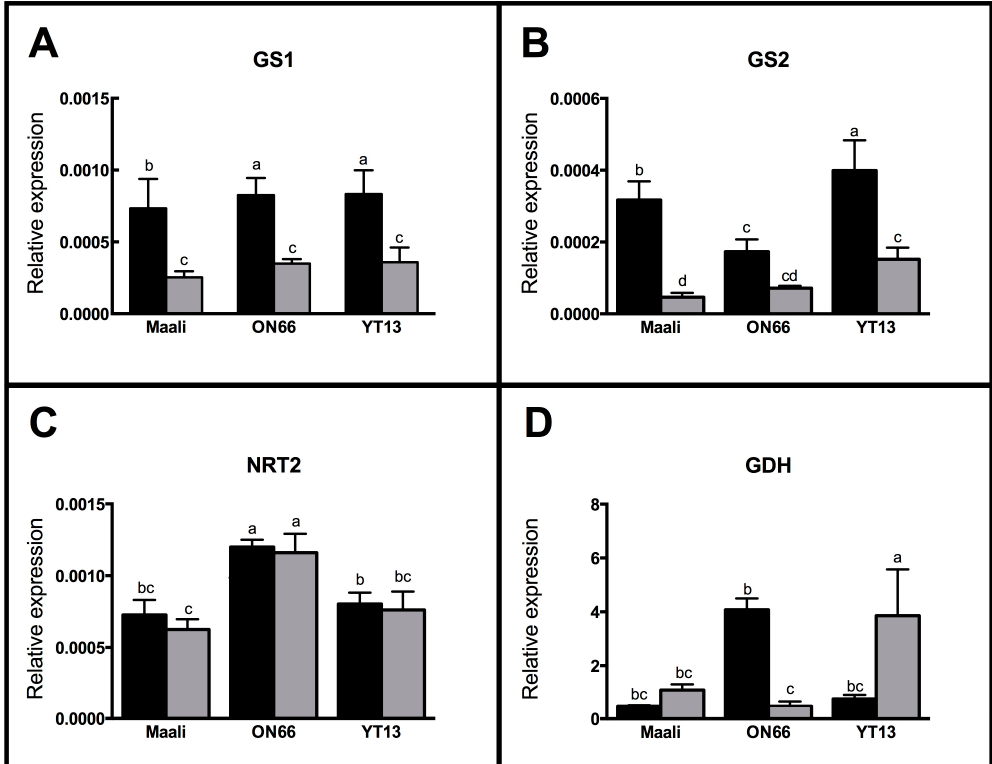
Figure 5. Changes in transcript abundance of GS1 ( A ), GS2 ( B ), NRT2.3 ( C ), and GDH ( D ) in leaves of durum wheat, measured by qRT-PCR. Variations are indicated as fold changes in stressed plants (grey bars) with respect to control (black bars). For each sample, the mRNA level was calculated relatively to the calibrator sample for the same gene. Letters indicate homogenous data. Other details in the text.